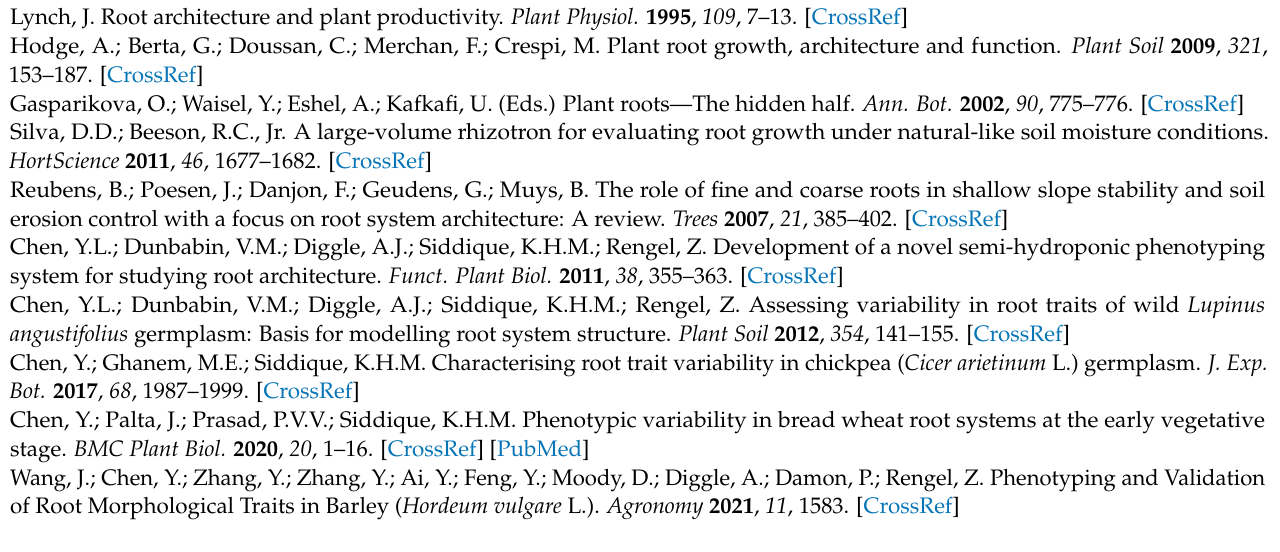
Table S3: Cumulative visible root length by root mapping through glass panels every 10 days from 17 days after sowing (DAS) to first flower time (eight genotypes) and maturity (two genotypes) once the roots of genotype PI 56127 reached the bottom of the 1.5 m-deep rhizoboxes (107 DAS). Values are the mean ± standard error of three replicates (two plants per rhizobox). ns: not significant. *, **, and *** indicate significant differences among genotypes at p < 0.05, p < 0.01, and p < 0.001,